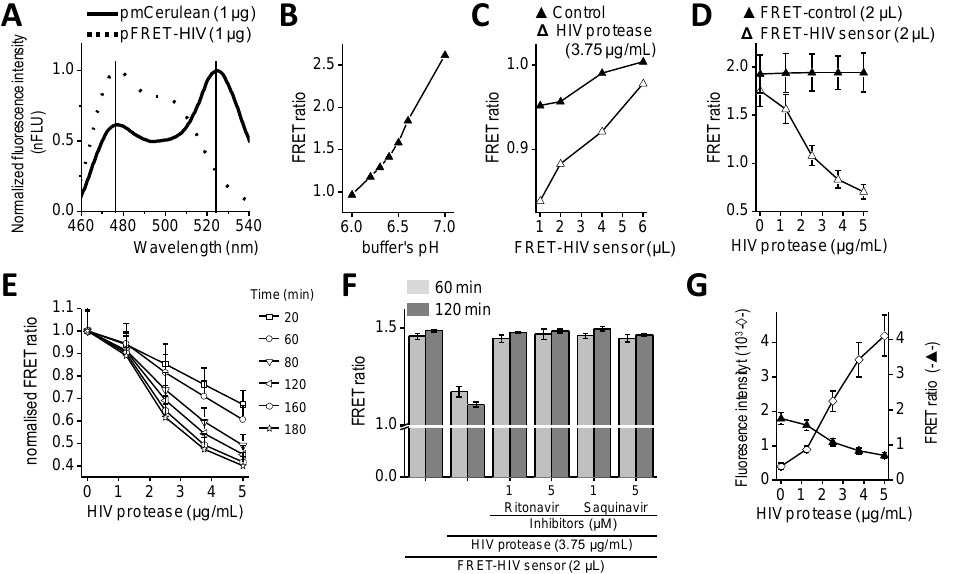
Figure 2. In vitro characterization of the FRET-HIV sensor. ( A ) Comparison of emission spectra of HEK293 cells transfected with plasmid coding for the FRET-HIV protease sensor (full line), the mCerulean fluorescent protein (dashed line) excited with a 433-nm light. ( B ) The FRET-HIV sensor is sensitive to pH. The FRET ratios (F /F ) of the FRET donor FRET-HIV sensor in buffers with a pH from 6.0 to 7.0 were determined to optimize the reaction buffer for the in vitro HIV protease activity assay. ( C ) Low concentration of the FRET-HIV sensor with respect to HIV protease increased sensitivity of the in vitro assay. An optimal ratio between the recombinant HIV protease and the FRET-HIV sensor was determined by varying the concentration of the FRET-HIV sensor at a constant concentration of recombinant HIV protease in the reaction mix. ( D ) A minimal, but still sufficient, concentration of recombinant HIV protease in reaction mix was established by reducing the HIV protease concentration at constant concentration of the FRET-HIV sensor. ( E ) Incubation for 2 h was optimal for the in vitro assay. The FRET ratio of the FRET-HIV sensor in the reaction mixtures containing different concentrations of HIV protease were followed for 3 h. ( F ) The in vitro assay that we developed was sensitive enough for inhibitor screening. Inhibitors (at a 1-μM final concentration) added to the reaction mixture inhibited the HIV protease, which was detected through the FRET